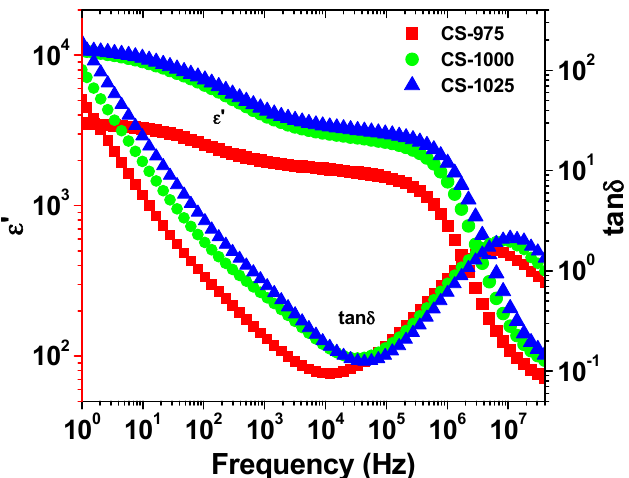
Figure 8. Frequency dependence of ε (cid:48) and tan δ at 300 K for LCTO ceramics.